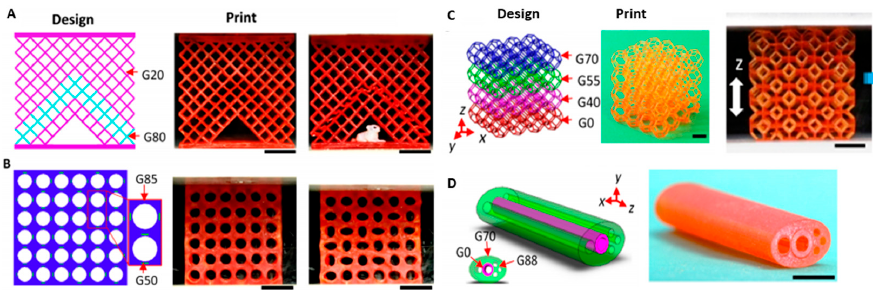
Figure 14. Design and print of graded metamaterial via g-DLP for multifunctional applications, in- cluding 2D lattice and cellular metamaterial for: ( A ) Controlled buckling; ( B ) pattern transformation; ( C ) 3D lattice metamaterial; ( D ) the design and print part of a limb-mimic structure. Scale bars, 1 cm. (Adapted with permission from reference [45]).